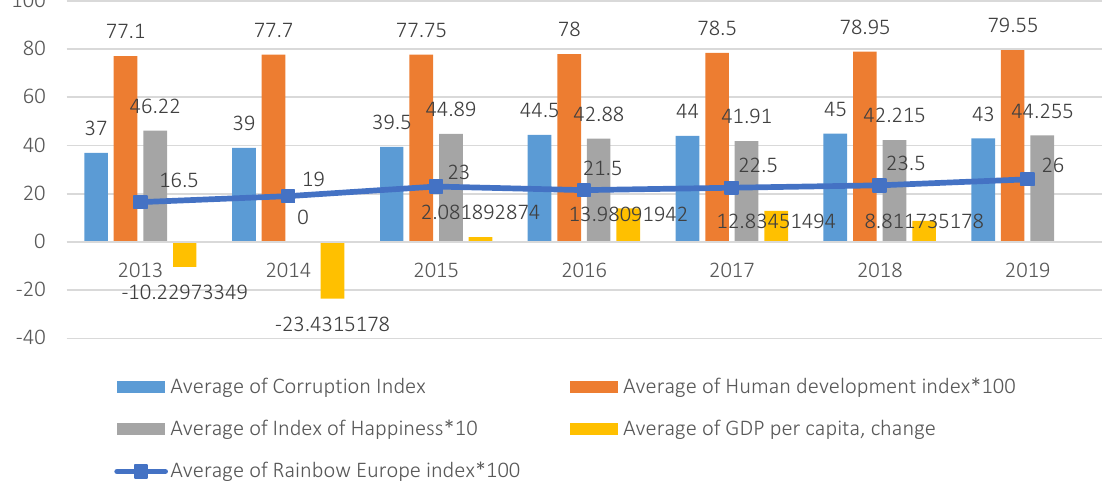
Figure 2. Average values of given indicators with a clear line of Rainbow Europe Index for Ukraine and